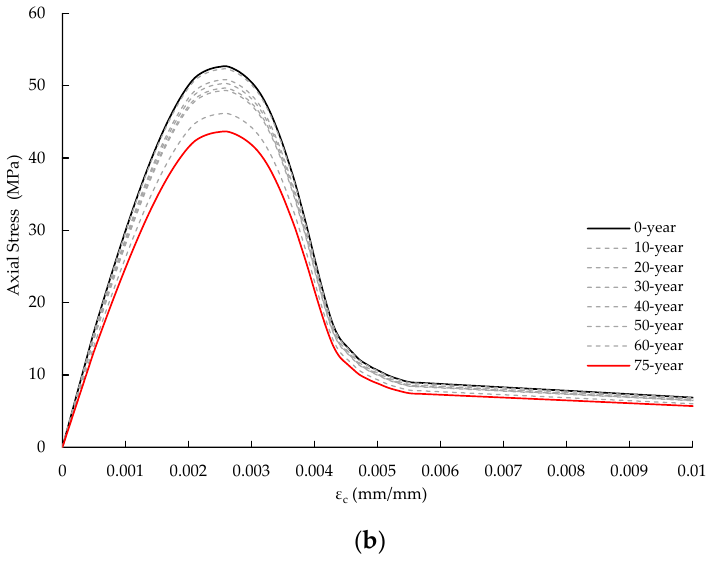
Figure 10. Concrete stress–strain relationships. ( a ) Cover concrete. ( b ) Core concrete.